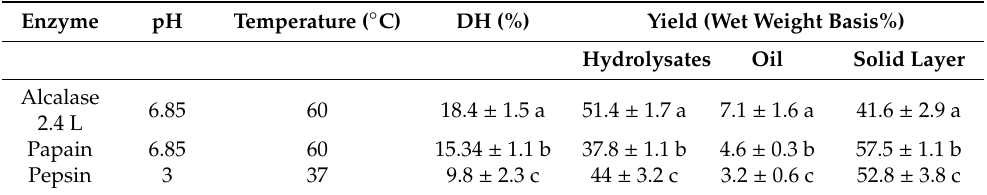
Table 1. Details of enzymes used, degree of hydrolysis and yield 1